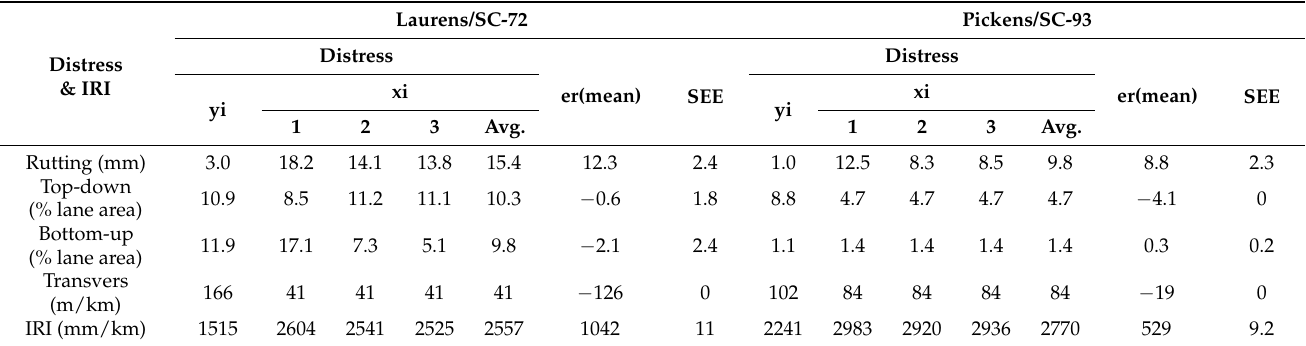
Table 7. Summary of measured and predicted distress